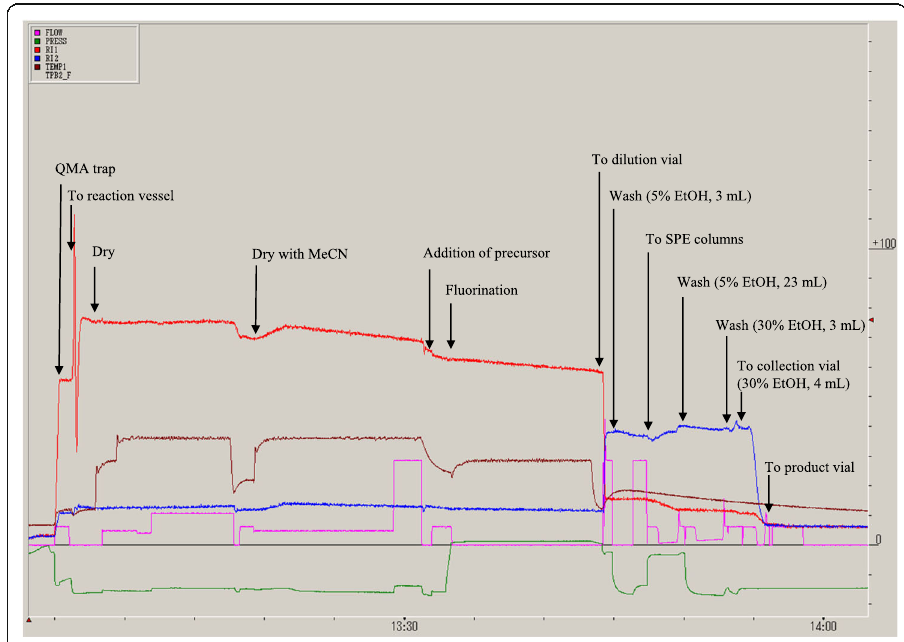
Fig. 5 The typical trend graph of [ 18 F]PSMA-1007 synthesis. Total synthesis time was 62 min on average. RI1 was installed via the reaction vessel (red line) and RI2 was installed via the dilution vial and solid phase extraction (SPE) columns (blue